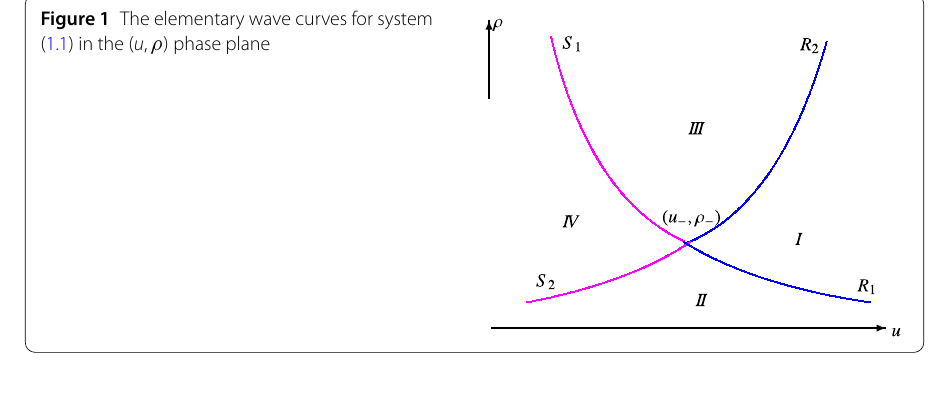
Figure 1 The elementary wave curves for system (1.1) in the ( u , ρ ) phase